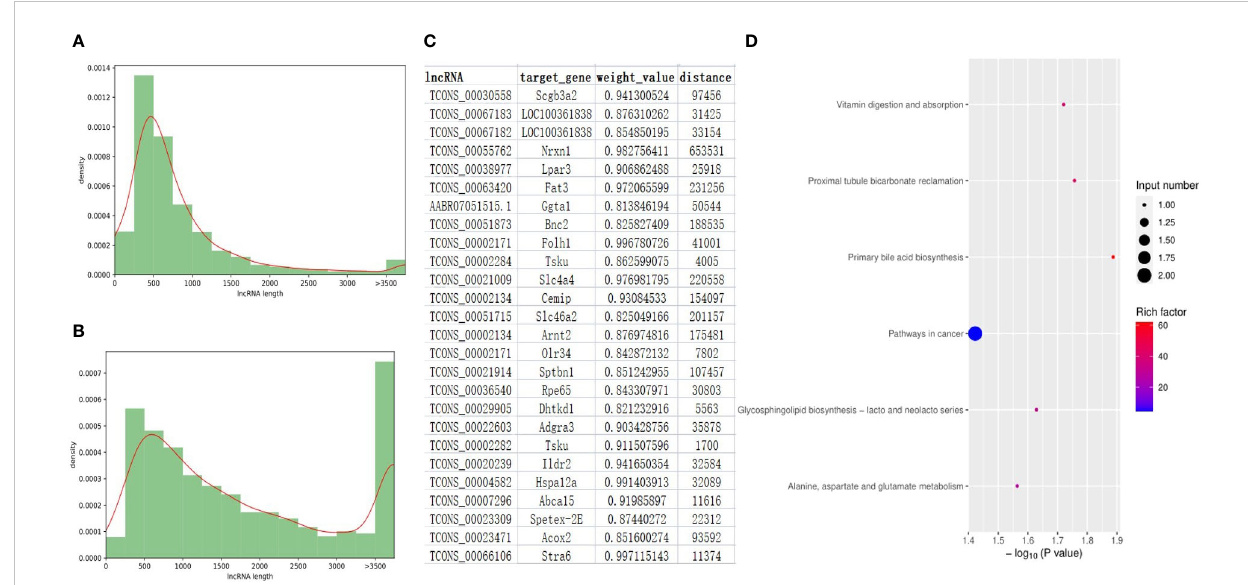
FIGURE 5 Features of lncRNA genes in the renal tissues of H-TPL rats. (A, B) Comparison of lengths between ALRGs (A) and novel lncRNAs (B, C) Pairs of SDElncs and 27 candidate target genes predicted by location and WGCNA; (D) KEGG terms of the 27 target